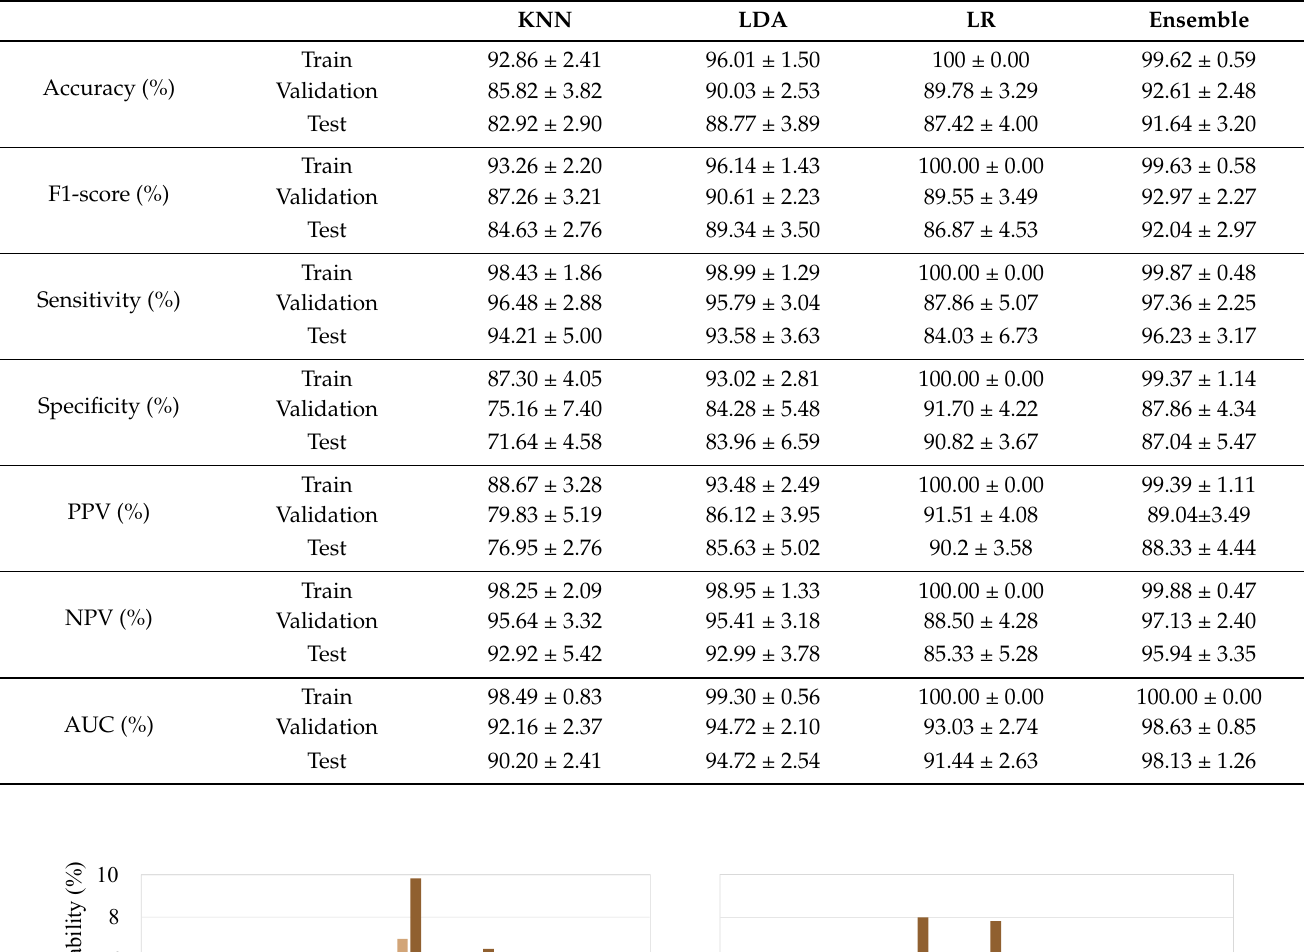
Table 3. Average performance of 30 partitions for base classifiers (LDA, LR and KNN) and for the classifiers’ ensemble.